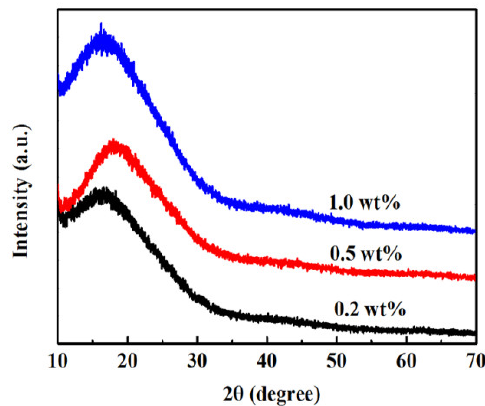
Figure 3. XRD patterns of porous PI films .